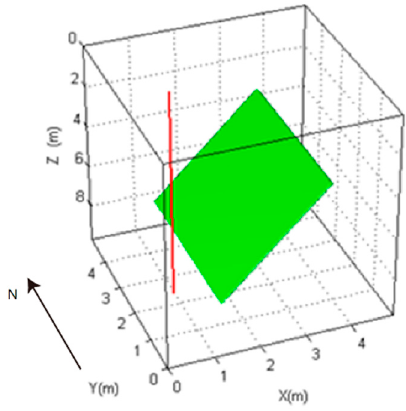
Figure 1. Model built to study the borehole non-uniformity influence on the received array signals (the red line represents for borehole).